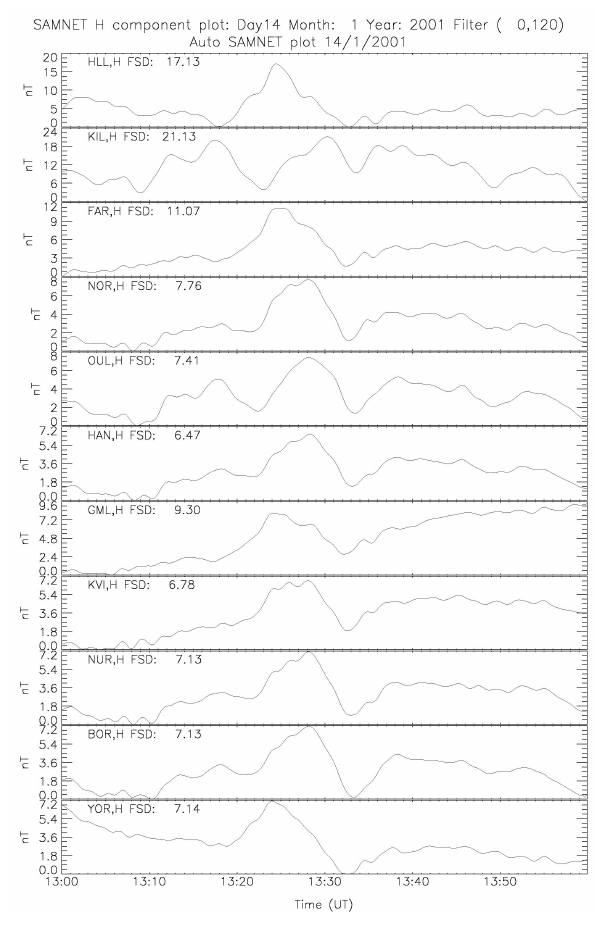
Fig. 10b. Horizontal component magnetograms from the SAMNET network, sorted from top to bottom along three longitudinal profiles at different latitudes (HLL–KIL, FAR–OUL, and